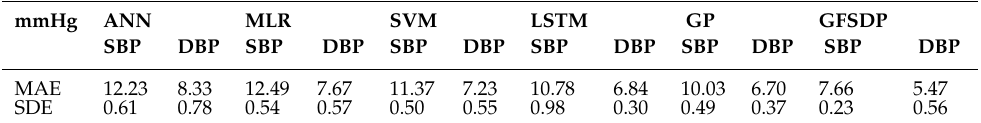
Table 7. MAE (SDE) relative to the reference ABP and the conventional ANN, MLR, SVM, LSTM, GP and using the proposed GFSDP algorithms.